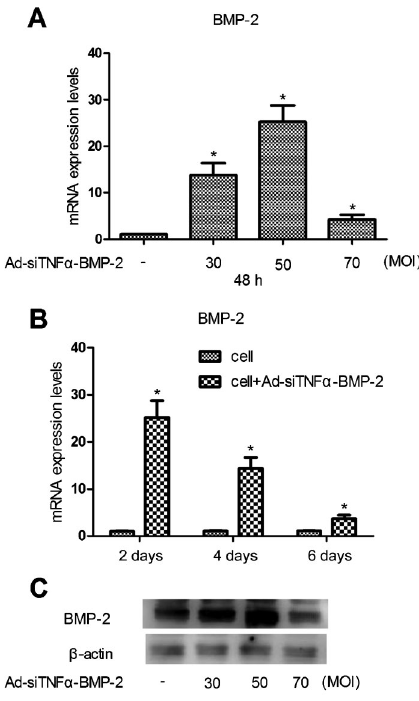
Figure 3. BMP-2 expression in MC3T3-E1 treated with Ad- siTNF a -BMP-2. A , MC3T3-E1 cells were plated on 6-well cluster plates at a density of 4 6 10 5 cells/well. After 24 h, MC3T3-E1 cells were treated with Ad-siTNF a -BMP-2 for 48 h. There was a